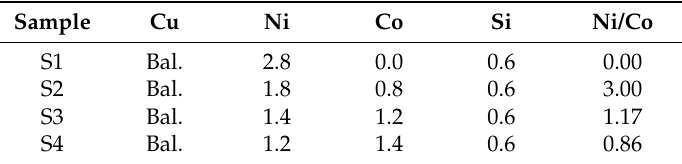
Table 1. Composition for the experimental alloy